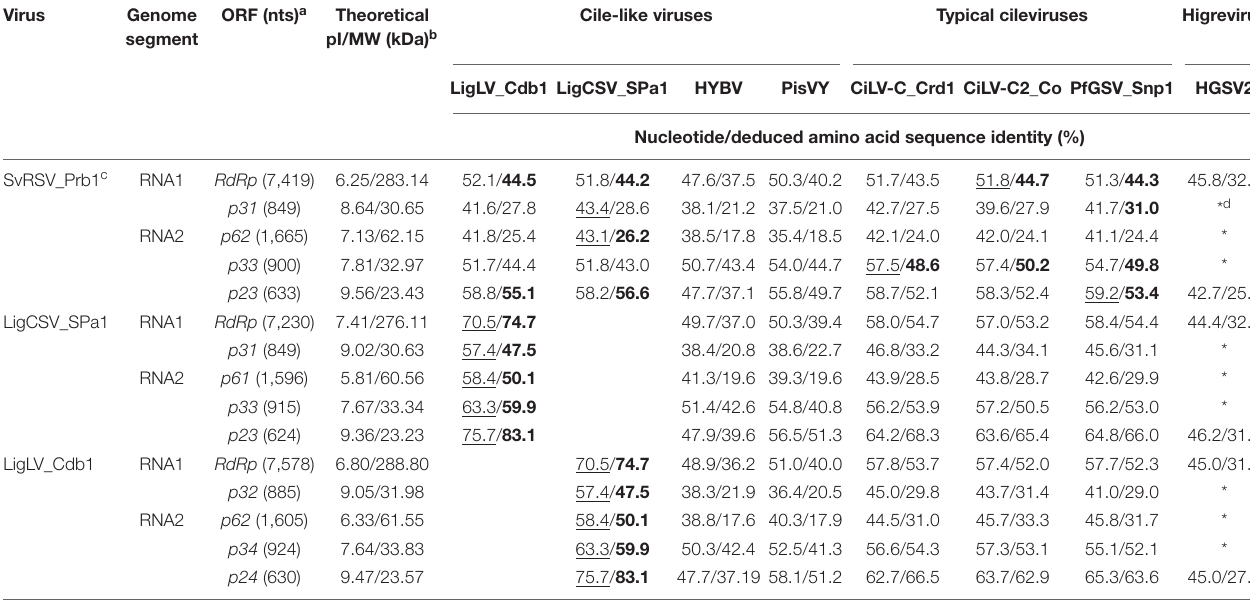
TABLE 4 | Nucleotide (nt) and deduced amino acid (aa) identities between SvRSV_Prb1, LigCSV_SPa1 and LigLV_Cdb1, and other tentative and definitive members of the family Kitaviridae . Virus Genome ORF (nts) a segment